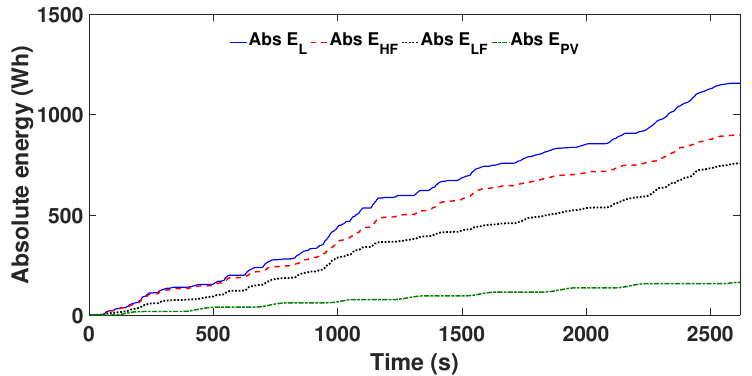
Figure 9. Absolute energy sharing